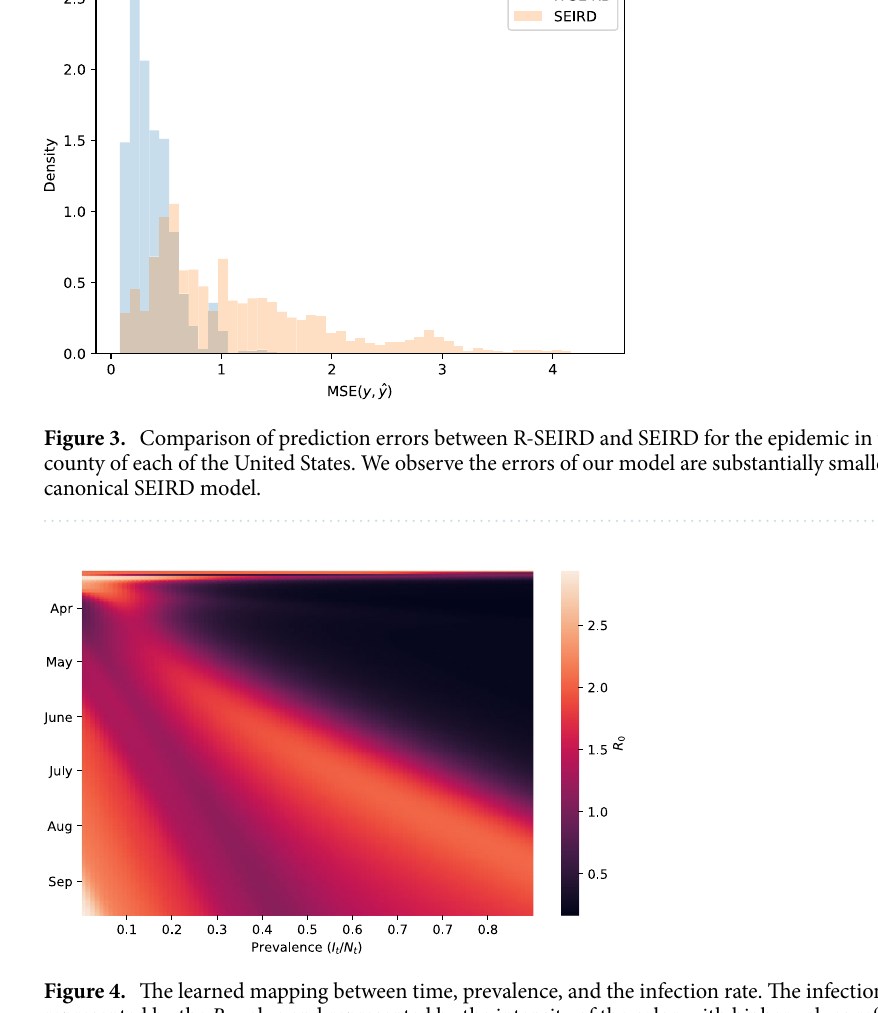
Figure 4. The learned mapping between time, prevalence, and the infection rate. The infection rate is represented by the R 0 value and represented by the intensity of the color, with higher values reflecting more a infectious disease. This analysis aids to the interpretability of the deep learning model. It can lead to meaningful insights about potential intervention